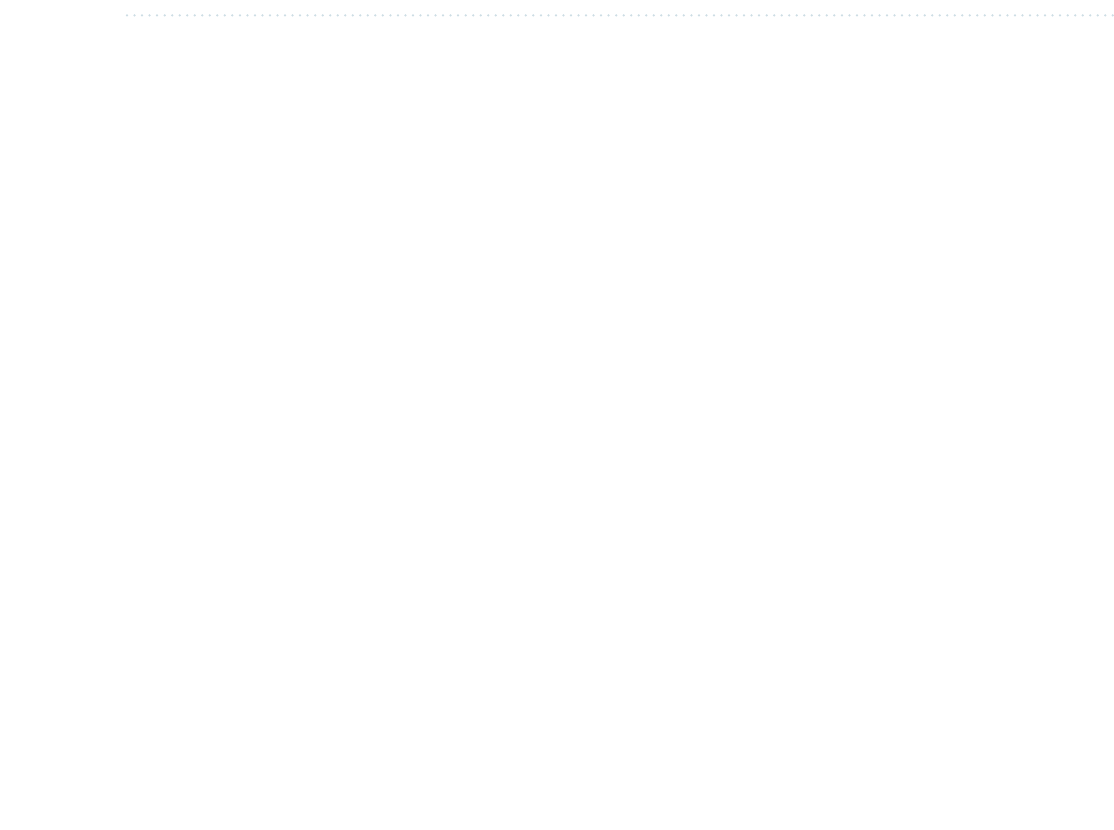
Figure 14. Force of the double circular saw blades with various spacings cutting